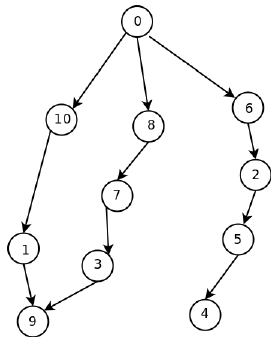
Figure 6. Network model example.